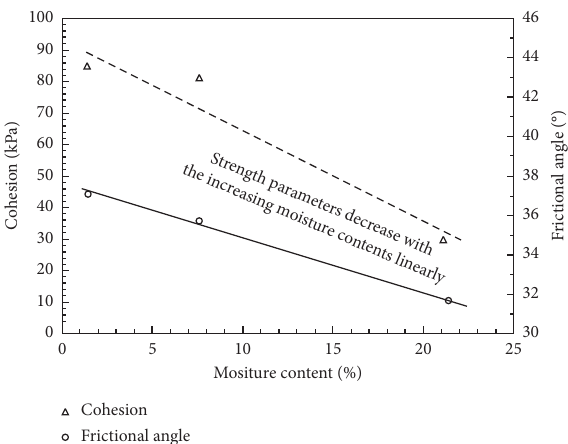
Figure 14: Strength parameters obtained from laboratory test versus moisture